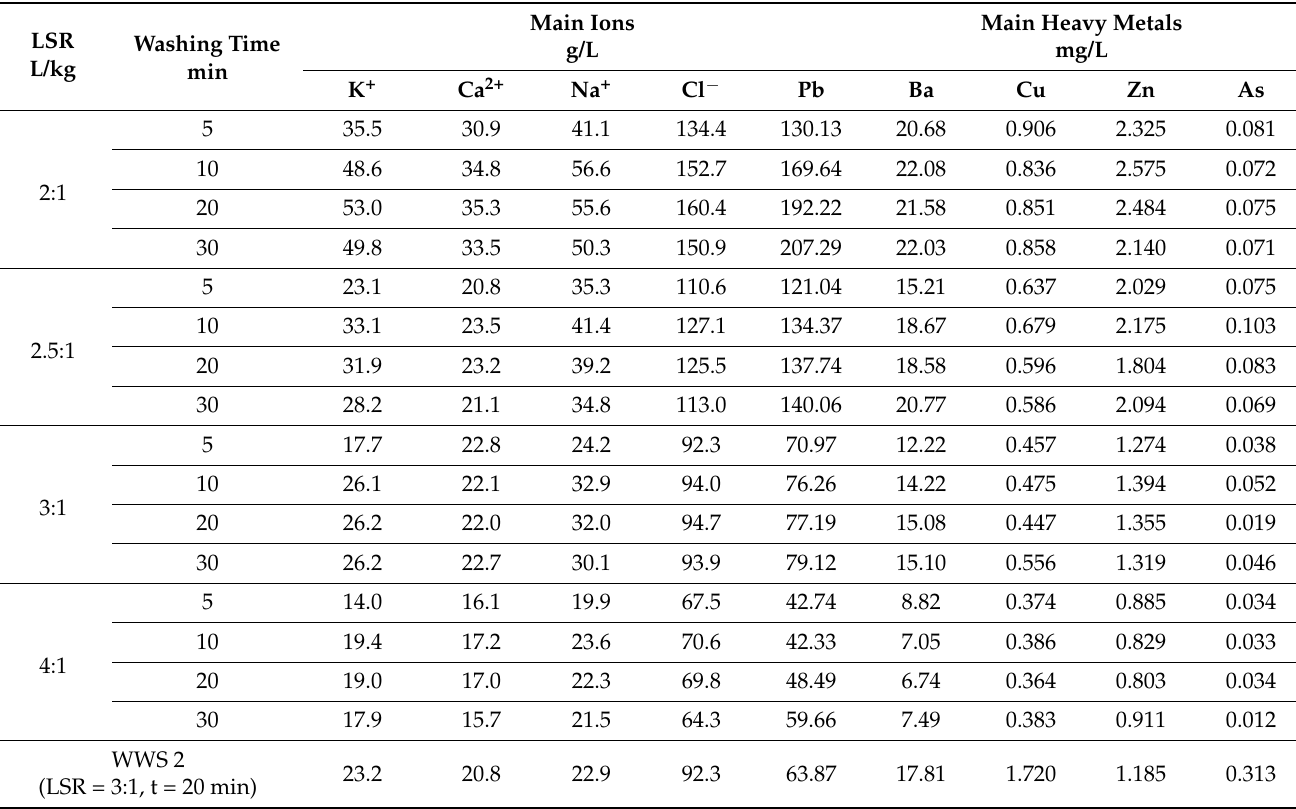
Table 3. The concentration of alkali metals, chlorine, and heavy metals under different washing